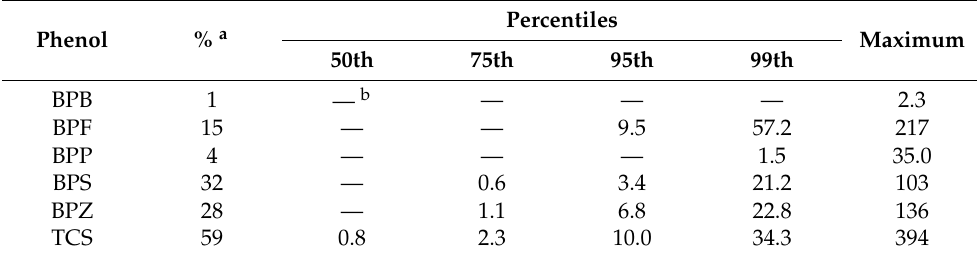
Table 2. Phenolic compound levels (ng/g) in 776 DDSF samples.